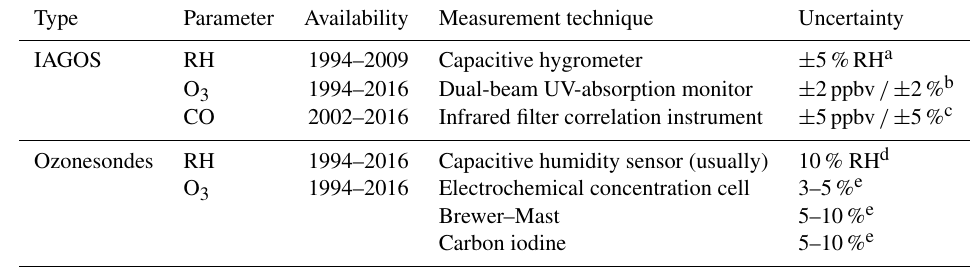
Table 1. Information relative to the measurements of the parameters used in this study (instrument, uncertainty and period of available data).